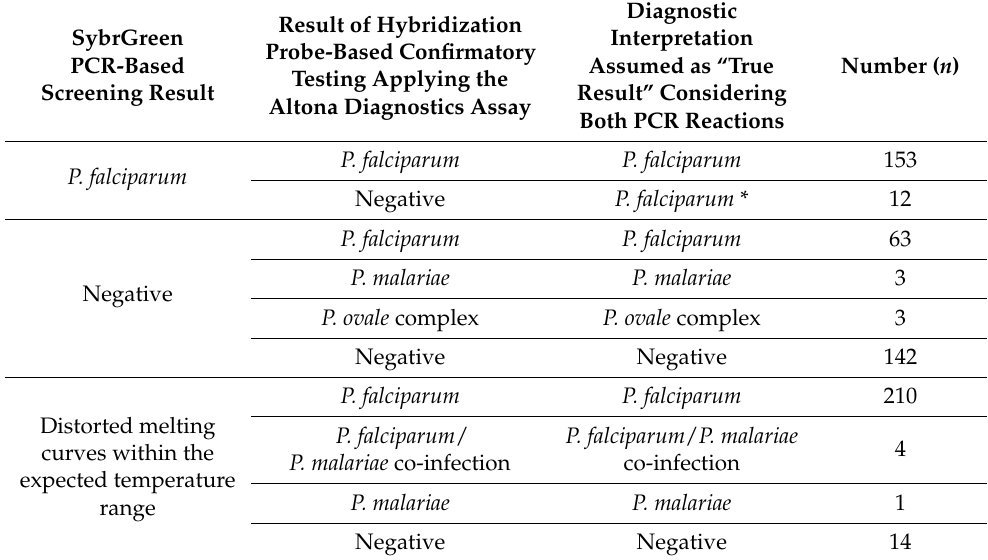
Table 3. Applied interpretation algorithm for the confirmatory testing applying the commercial hybridization probe-based Altona Diagnostics real-time PCR assay ( n = 605).